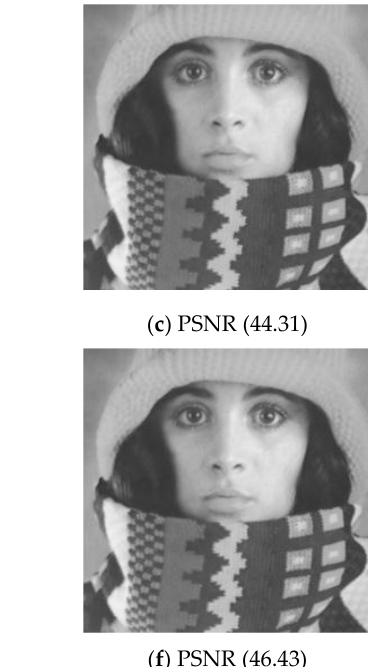
Figure 3. Noised “ Girl_face ” image by 10% fixed value impulse noise and its restored images by different state-of-art and their PSNR. ( a ) Noisy “ Girl_face ” image ( b ) EDF+BDND ( c ) IGMF+FTD ( d ) ASWMF+D3PLS ( e ) NBMF+VTD ( f ) The proposed state-of-art.